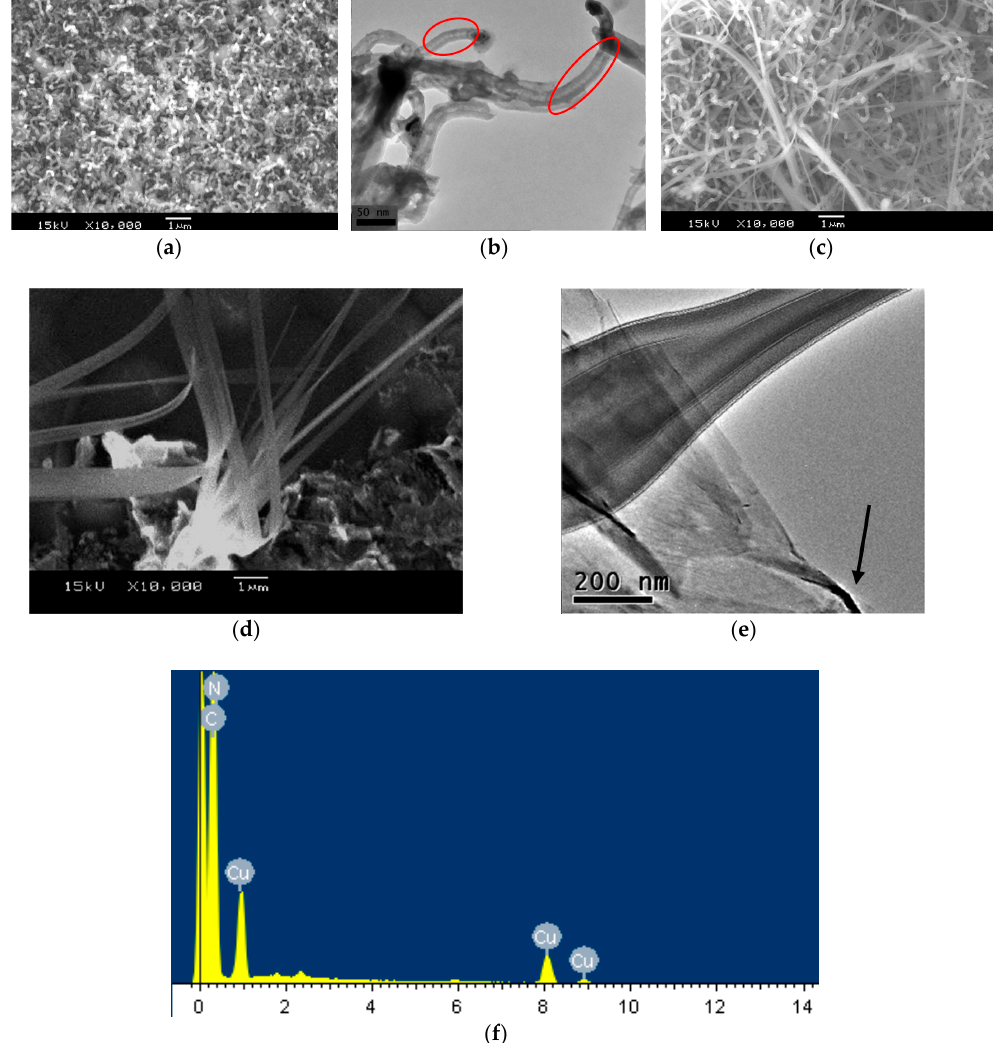
Figure 3. SEM ( a ) and TEM ( b ) images of carbon nanotubes (CNTs) grown on 100 nm Cu catalysts in